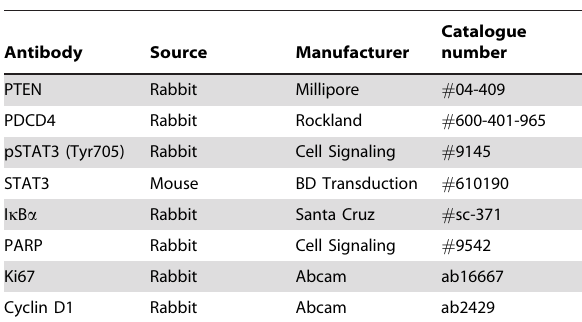
Table 1. Antibodies used.